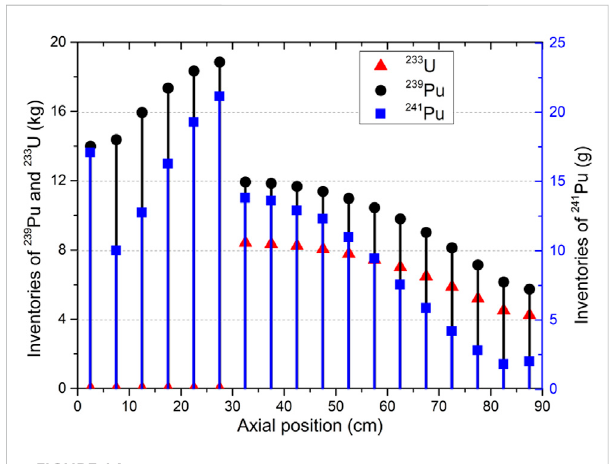
FIGURE 14 Productions of 239 Pu, 241 Pu, and 233 U per small zones at the EOC.